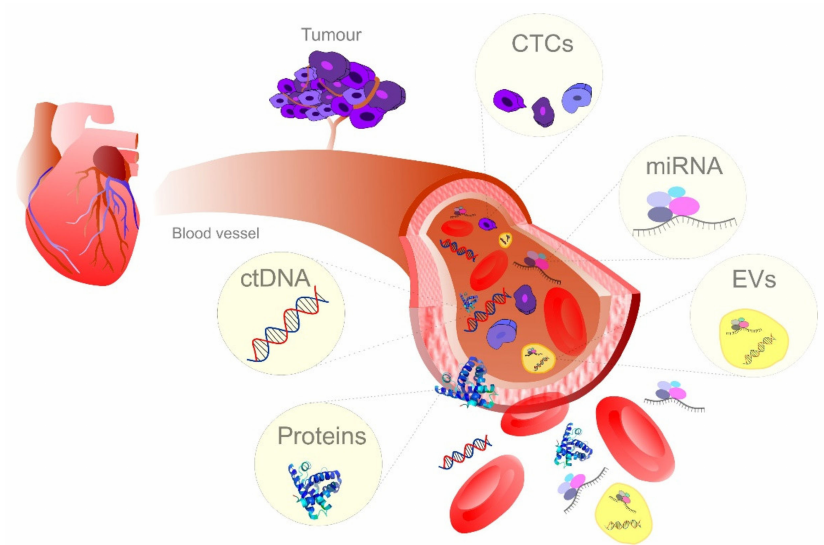
Figure 2. Blood-basedcancerbiomarkersinliquidbiopsy. CTC,circulatingtumorcells; ctDNA,Circulating: tumor cell-free DNA; EVs, extracellular